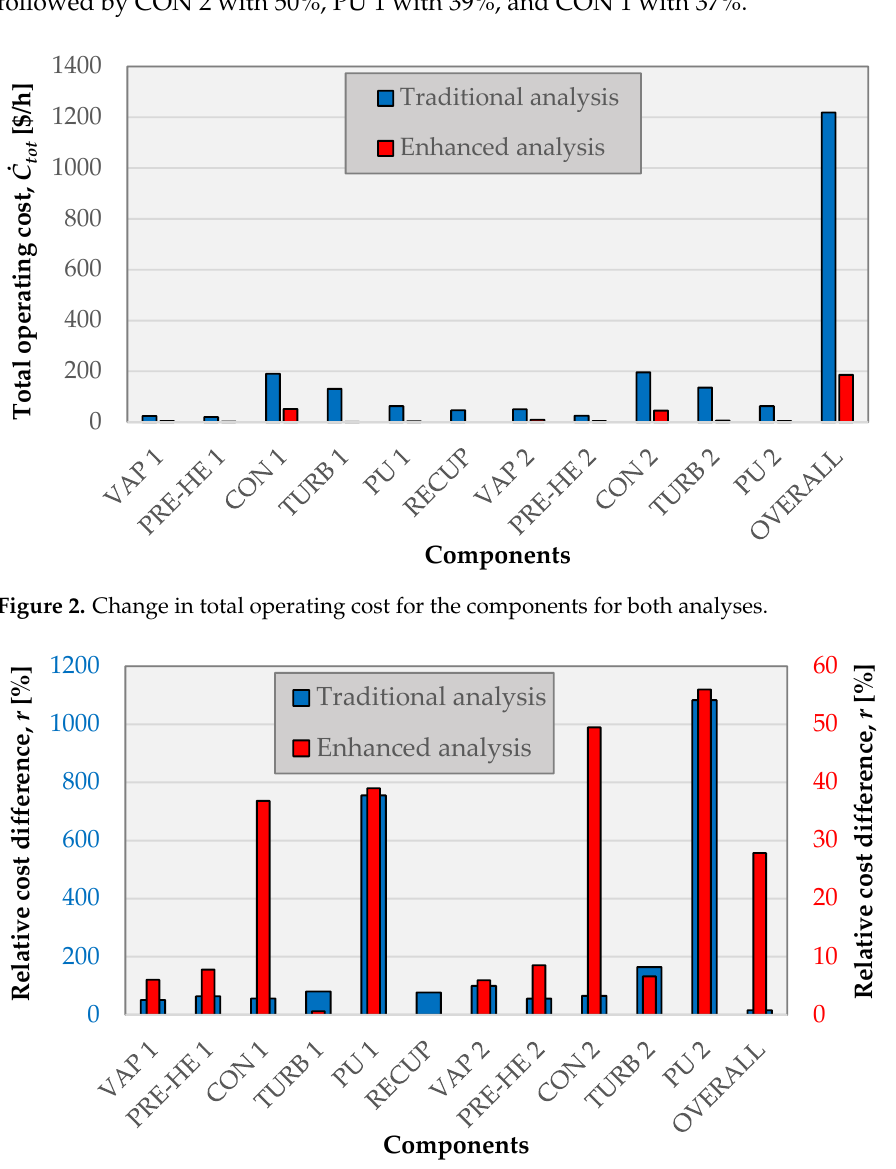
Figure 3. Change in relative cost difference for the components for both analyses.